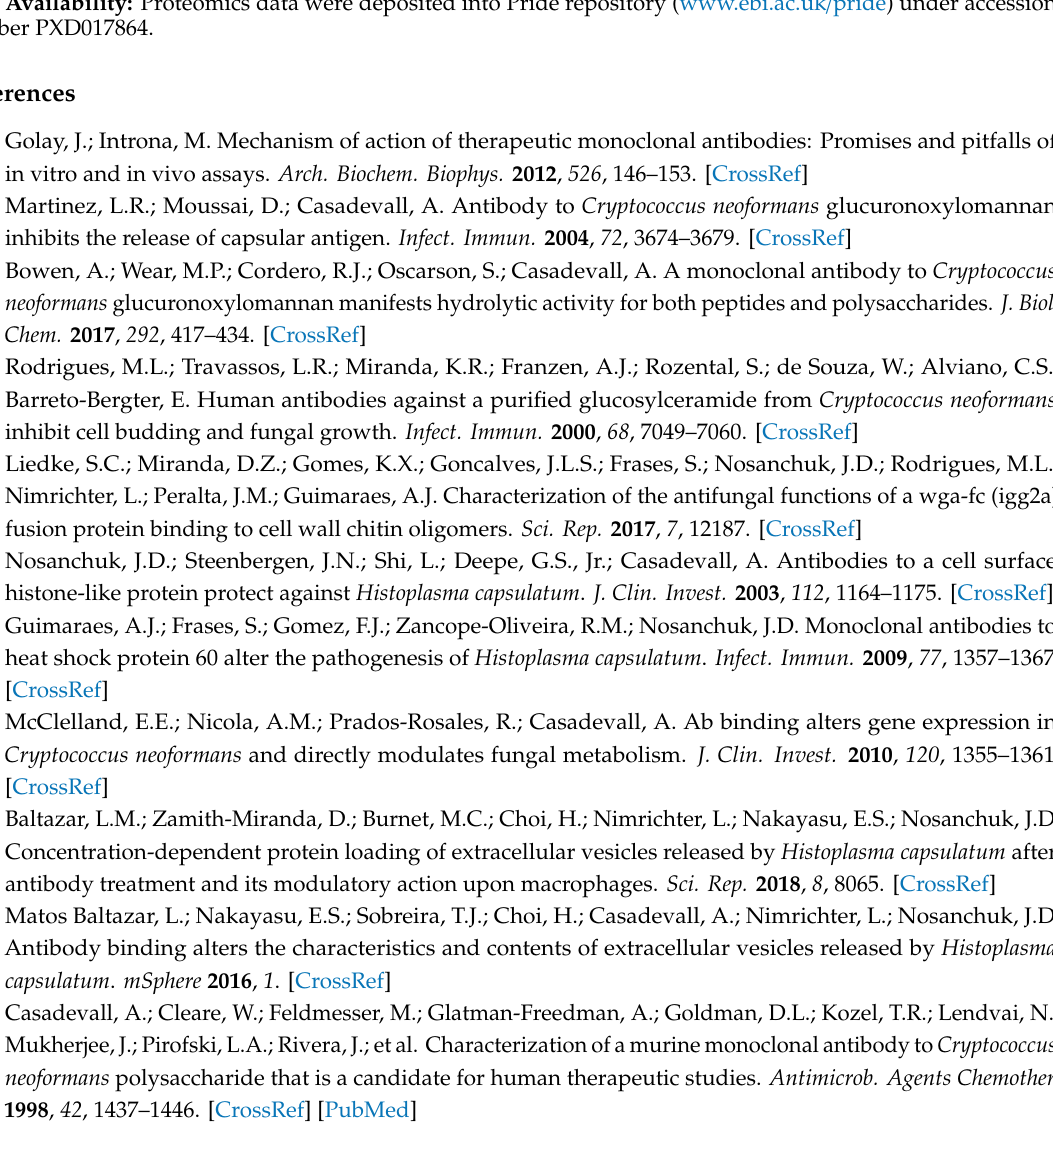
Table S3. Function enrichment analysis. Histoplasma capsulatum proteins that were di ff erentially expressed with the antibody treatment were submitted to a function-enrichment analysis using the KEGG annotation. Pathways were filtered with a fold enrichment ≥ 2, p -value ≤ 0.05 and ≥ 2 proteins per